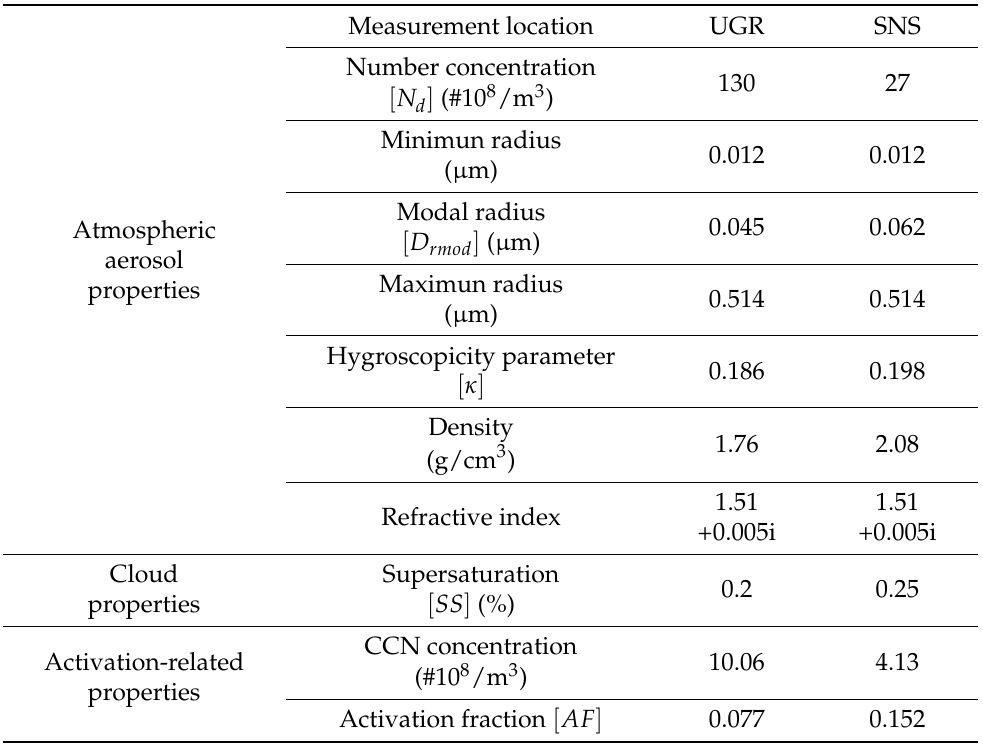
Table 4. Atmospheric and cloud parameter used for LARSS